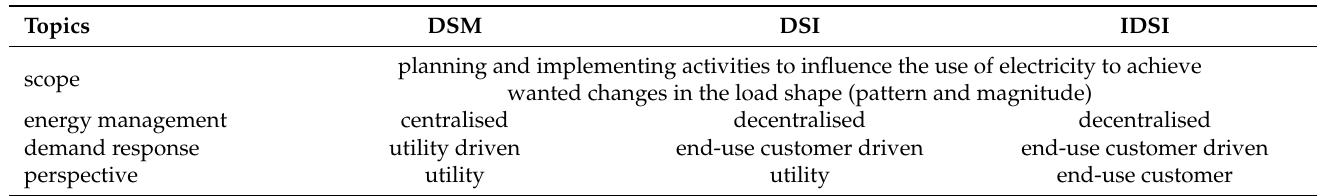
Table 1. Similarities and differences between the different